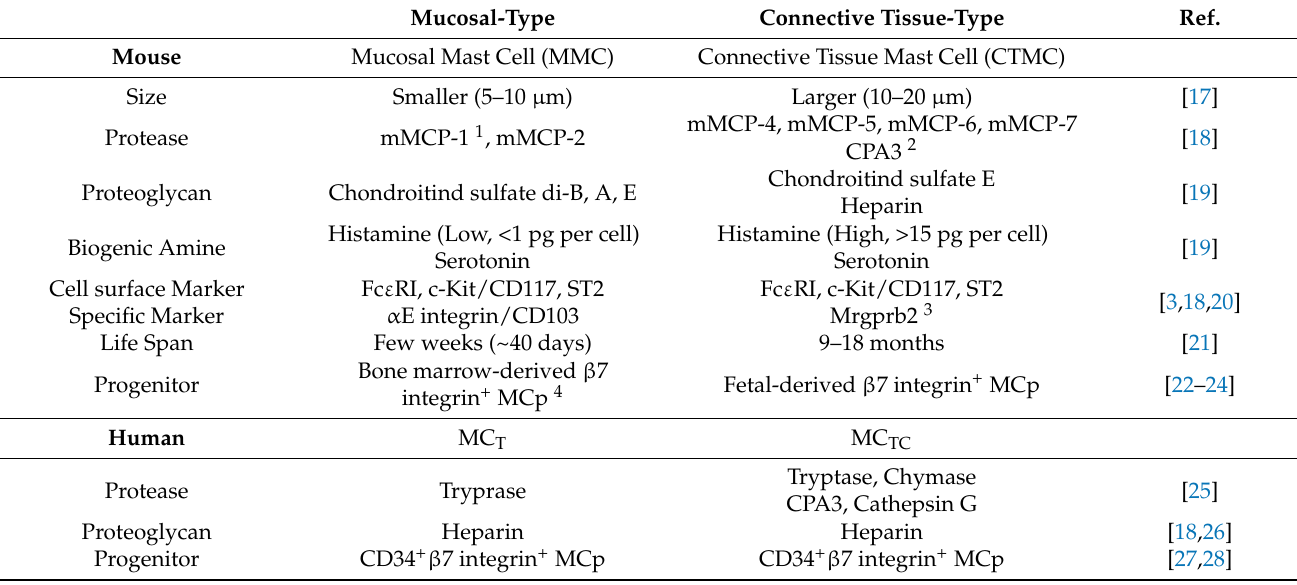
Table 1. Characteristics of mast cell subtypes. Mucosal-Type Connective Tissue-Type